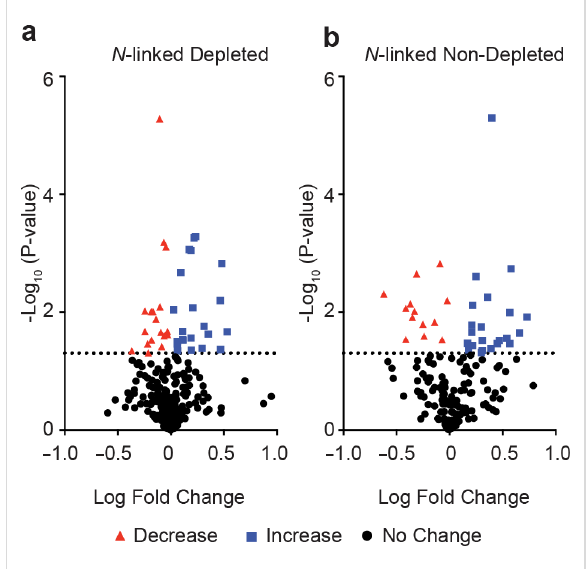
Figure 2: N -Glycoproteome profiling with GlypNirO. Volcano plots of site-specific N -glycoform relative abundance in HCC patients versus healthy controls in (a) depleted, and (b) non-depleted plasma.